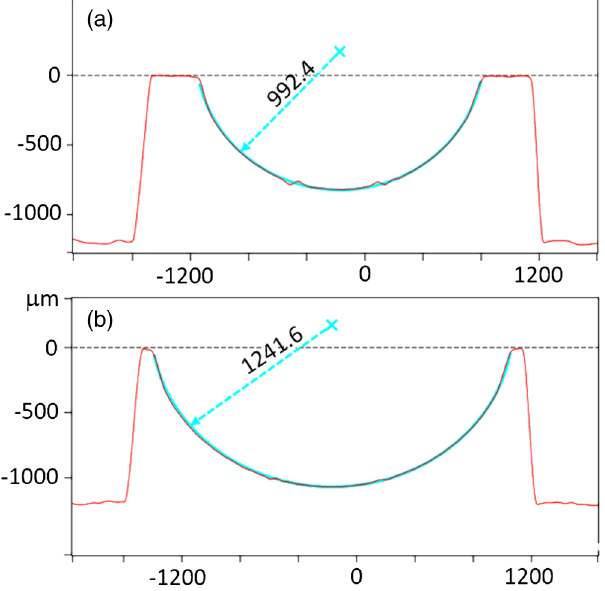
FIG. 7. The corrugation radii for (a) groove and for (b) tooth. All dimensions are in microns.